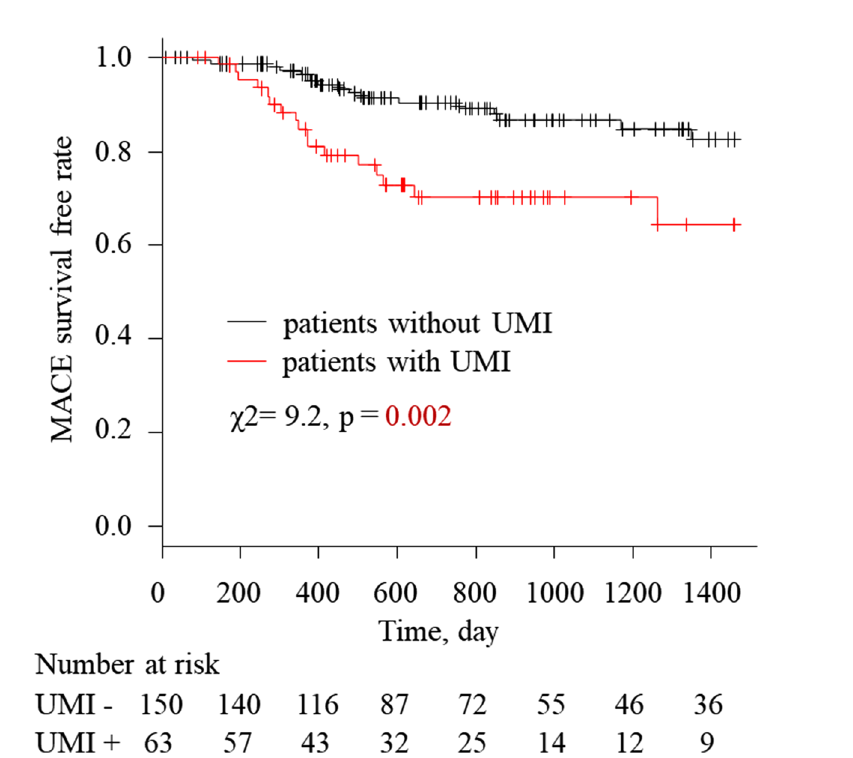
Figure 3. Kaplan–Meier analysis for the incidence of primary MACE according to the presence of UMI. The incidence of primary MACE was significantly higher in patients with UMI than that in those without